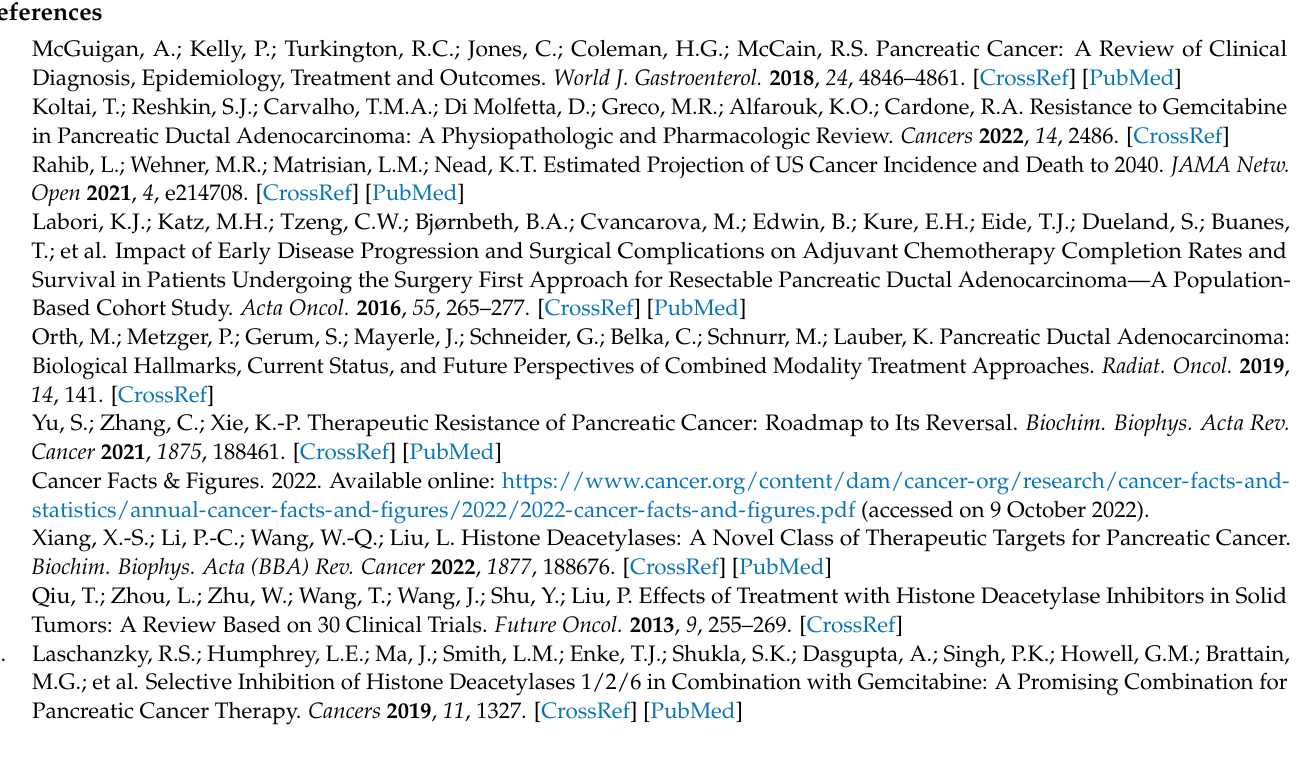
Table S2: The results of pathway enrichment analysis; Table S3: Additional network centrality analysis; Supplementary Note S1: Detailed results of experimental evaluation of synergisms with concentration